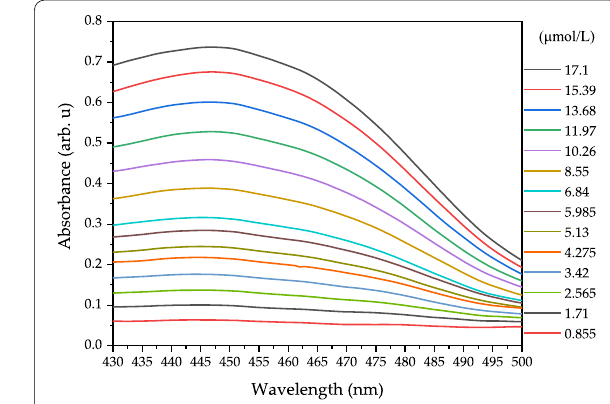
Fig. 8 Absorbance spectrum of direct bilirubin at different concentrations measured using the blue Mini‑LEDs MOD